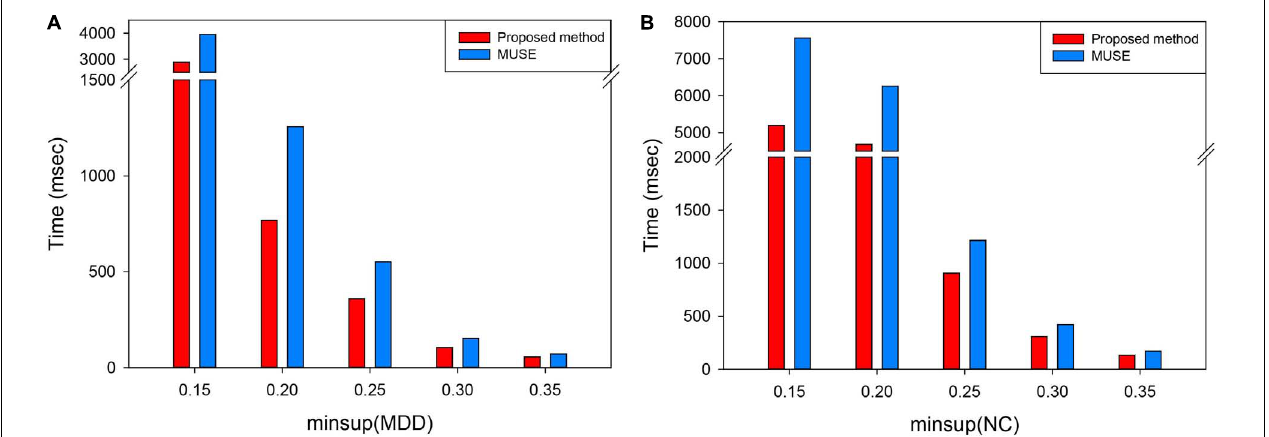
FIGURE 8 | Time complexity under each minsup in two groups of subjects. (A) Refers to the execution time mining frequent subgraph under each minsup in MDD group. (B) Refers to the execution time mining frequent subgraph under each minsup in NC group. MUSE represents traditional the mining uncertain subgraph patterns algorithm. The proposed method represents unFEPG and dfsSI methods. “msec” refers to millisecond.